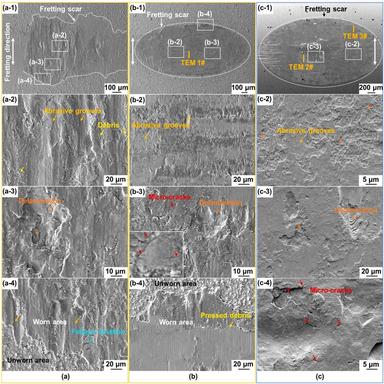
Surface morphologies and the corresponding element distribution of worn areas of claddings with different frequency. (a) Cr-coated cladding tested under 5 Hz; (b) Cr-coated cladding tested under 20 Hz; (c) uncoated cladding tested under 20 Hz.